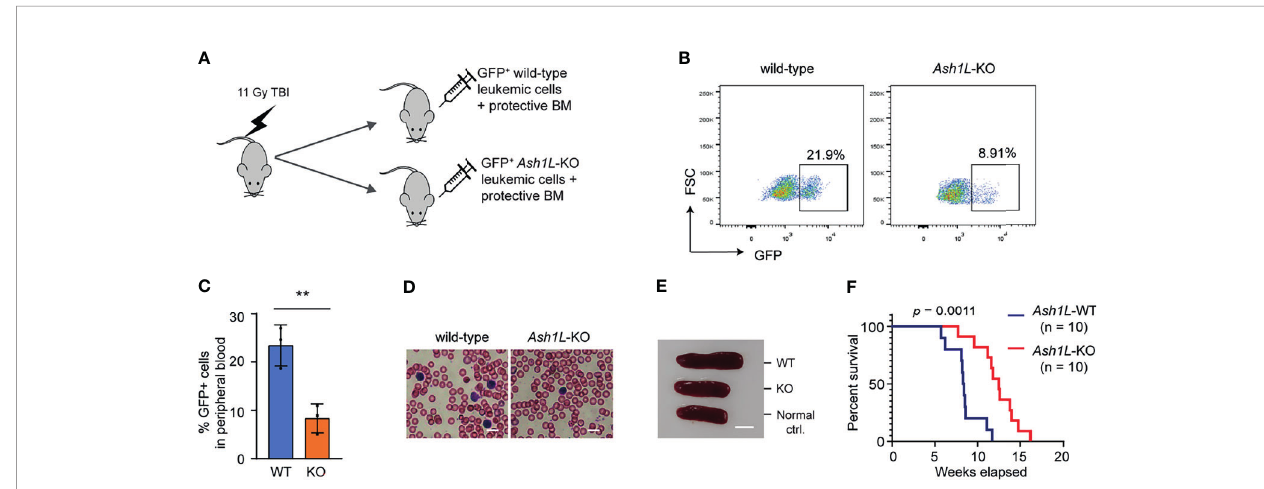
FIGURE 3 | ASH1L promotes the MLL-AF9-induced leukemia development in vivo . (A) Schematic experimental procedure. (B) Representative FACS analysis showing the GFP+ leukemic cell populations in the peripheral blood of mice transplanted with wild-type or Ash1L -KO MLL-AF9-transformed cells. (C) Quantitative results showing the percentage of GFP+ leukemic cell populations in the peripheral blood of mice transplanted with wild-type or Ash1L -KO MLL-AF9-transformed cells. The error bars represent mean ± SEM, n = 3 per group. ** P < 0.01. (D) Photos showing the leukemic cells in the peripheral blood smear of mice transplanted with wild-type or Ash1L -KO MLL-AF9-transformed cells. Bar = 10 µm. (E) Photos showing the representative spleen size from the normal control mice (Normal ctrl.), mice transplanted with wild-type (WT) or Ash1L -KO (KO) MLL-AF9-transformed cells. The samples were collected at post-transplantation 4 weeks. Bar = 5 mm. (F) Kaplan-Meier survival curve of mice transplanted with wild-type or Ash1L -KO MLL-AF9-transformed cells. P value calculated using a Gehan-Breslow-Wilcoxon test. n = 10 mice per